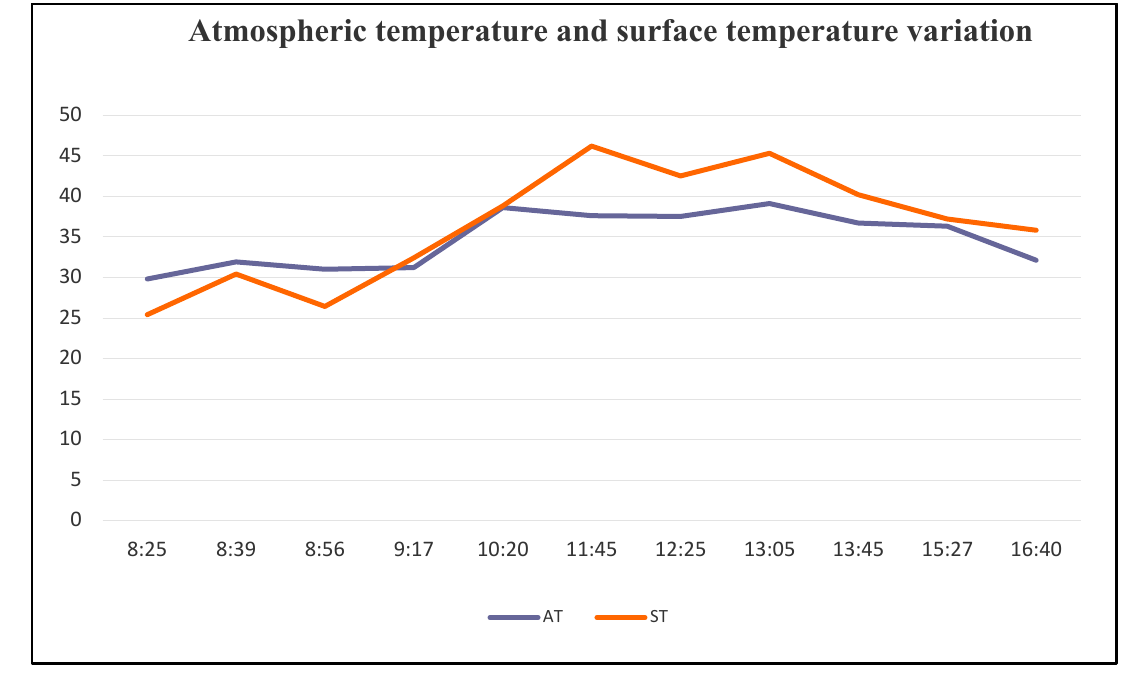
Figure 5. Variation between atmospheric temperature (AT) and land surface temperature (ST) on 29 March 2019.